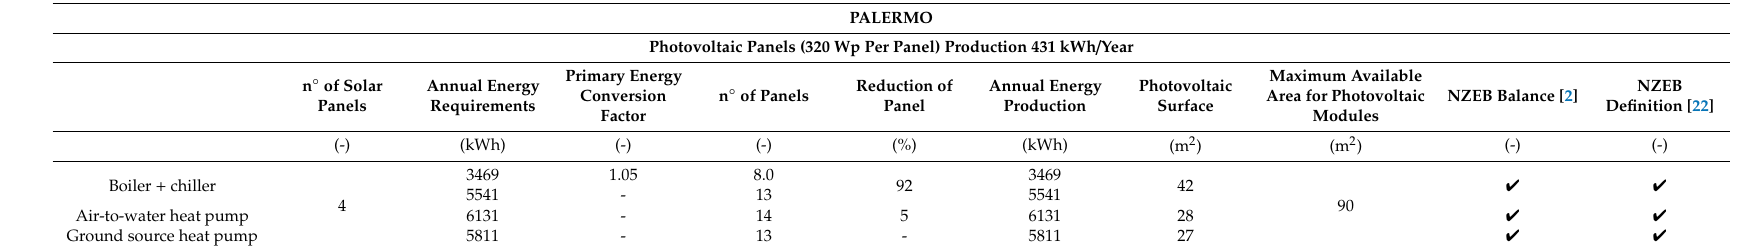
Table 7. Yearly energy balance for obtaining a NZEB in the case of Palermo.